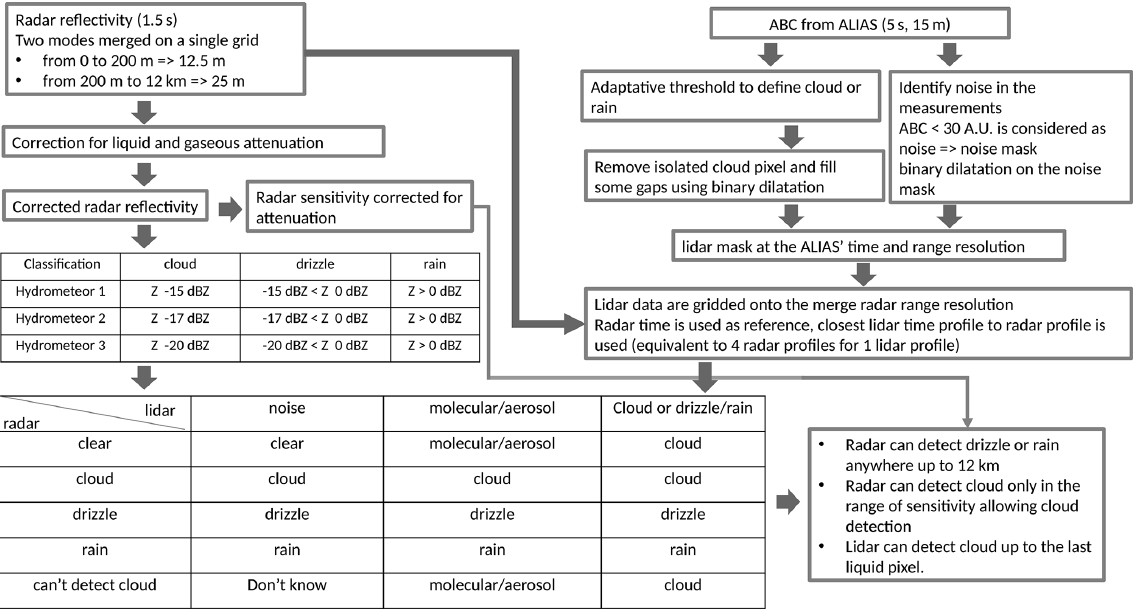
Figure 12. Cloud detection algorithm applied to BASTA and ALiAS data to detect hydrometeors (clouds, drizzle and rain).